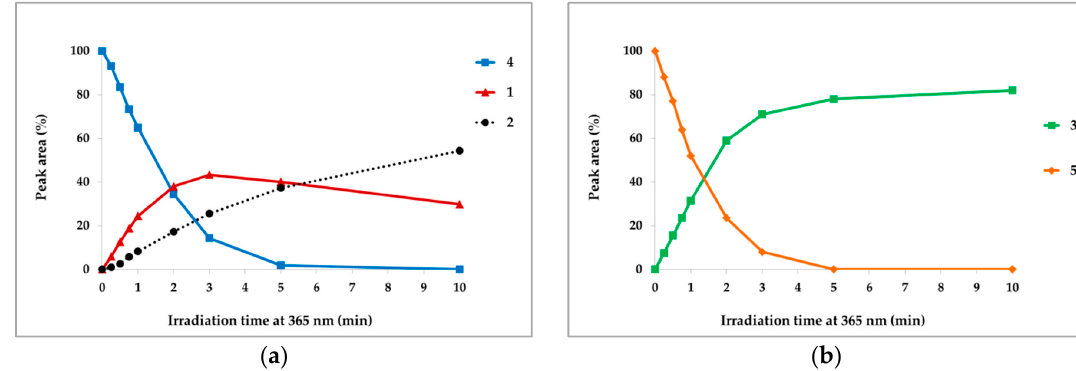
Figure 5. Release of parent VEGFR-2 inhibitors by irradiating their caged prodrugs. The DMNB-protected derivatives were irradiated at 365 nm with 5.4 W for up to 10 min. The uncaging was examined by HPLC and LC-MS analysis. The detection wavelength for the HPLC analysis was 300 nm. The amount of released parent compounds and their caged prodrugs are plotted as areas under HPLC-peaks against irradiation time. ( a ) Irradiation of 1 mM solution of 4 in DMSO (blue line) yields initially the maleimide 1 (red line). Continuing UV exposure leads to 1,6- π -electrocyclization of 1 to 2 (dotted black line); ( b ) Irradiation of 1 mM solution of 5 in DMSO (orange line) results in the clean release of carbazole 3 (green line).